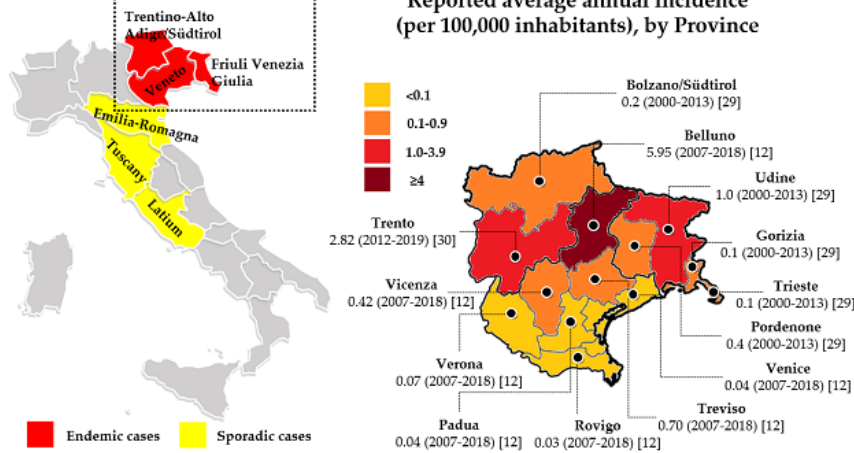
Figure 2. Map of the Italy showing areas where TBE is present. The average annual incidence in the north-eastern area is shown in detail [12,29,30].